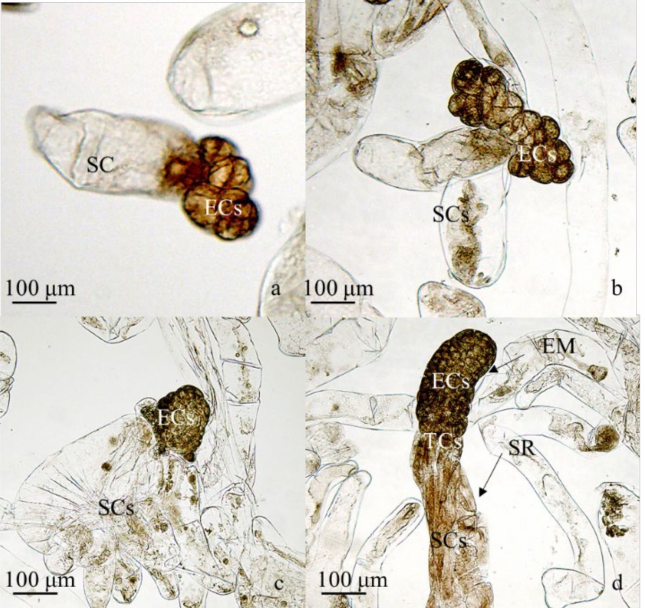
Figure 1. Characterization of the P. koraiensis embryogenic tissue. ( a ) PE I, bar = 100 µ m; ( b ) PE II, bar = 100 µ m; ( c ) PE III, bar = 100 µ m; ( d ) ESE, bar = 100 µ m. EM: embryo mass; TC: embryonic tube cells; SR: suspensor region; EC: embryonic cell; SC: suspensor cord-like cell. Even though all of the cell lines obtained had PE I, PE II, PE III, and ESE, there were significant variations in cotyledonary SE yield between cell lines during the maturation process ( p = 0.001). We tested the SE maturation ability in 11 cell lines. Among them, only five cell lines showed cotyledonary SEs after two months of cultivation on the SE maturation medium (the cotyledonary SE yield was 45–177 SEs g − 1 FW). The remaining cell lines did not mature in response to maturation treatment. Based on the maturation results of cotyledonary SEs, we defined the 1-1, 1-19, 1-100, 8-7, and 8-18 cell lines with somatic embryogenesis as response cell lines (R cell lines), and the 1-23, 1-102, 8-11, 8-16, 8-25, and 8-30 cell lines without somatic embryogenesis as obstructive cell lines (B cell lines) (Figure